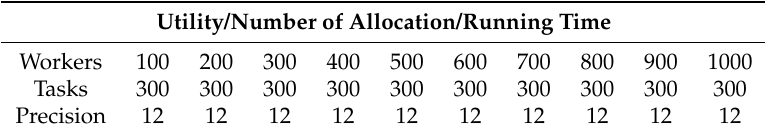
Table 4. Experimental settings for effect of the small-scale